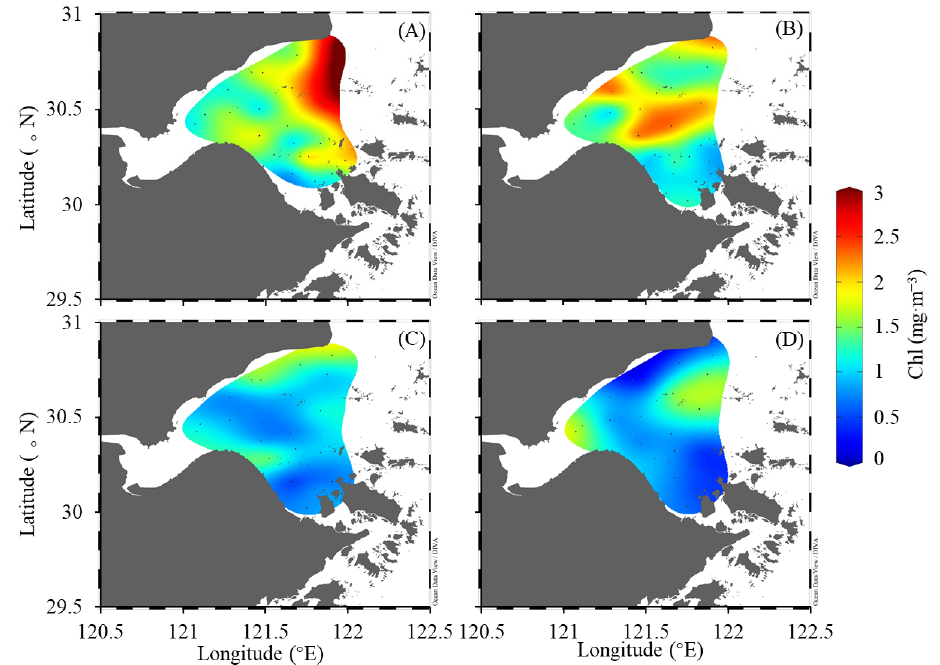
Figure 4. Spatial and temporal variations of Chl (mg · m − 3 ) in ( A ) July 2006, ( B ) December 2006, ( C ) April 2007 and ( D ) autumn.